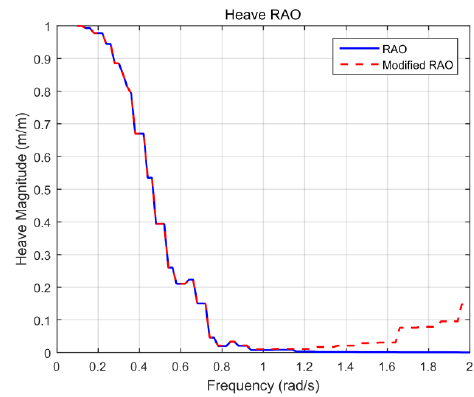
Figure 15. Modified Heave response amplitude operator (RAO) (red dotted line) of FPSO.